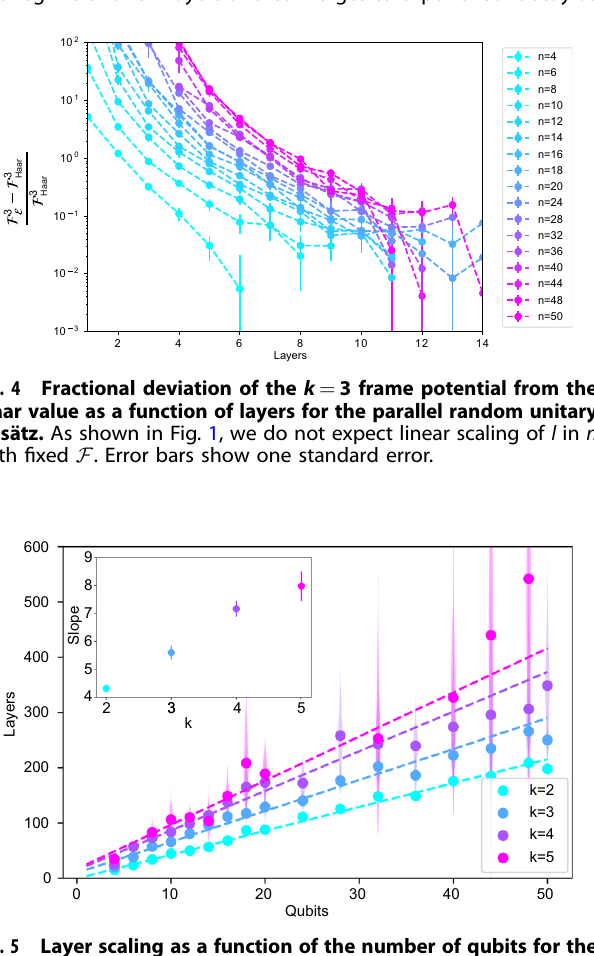
Fig. 5 Layer scaling as a function of the number of qubits for the parallel random unitary ansätz on a violin plot. Solid points are medians of the bootstrap sample, and the vertical shadows represent the sample distribution where the width corresponds to the density. Missing data points are due to insuf fi cient data (see the Supplementary Discussions 3.1 for more details). Dashed lines are linear fi ts. The inset shows the fi tted slopes for different k values. Error bars show one standard